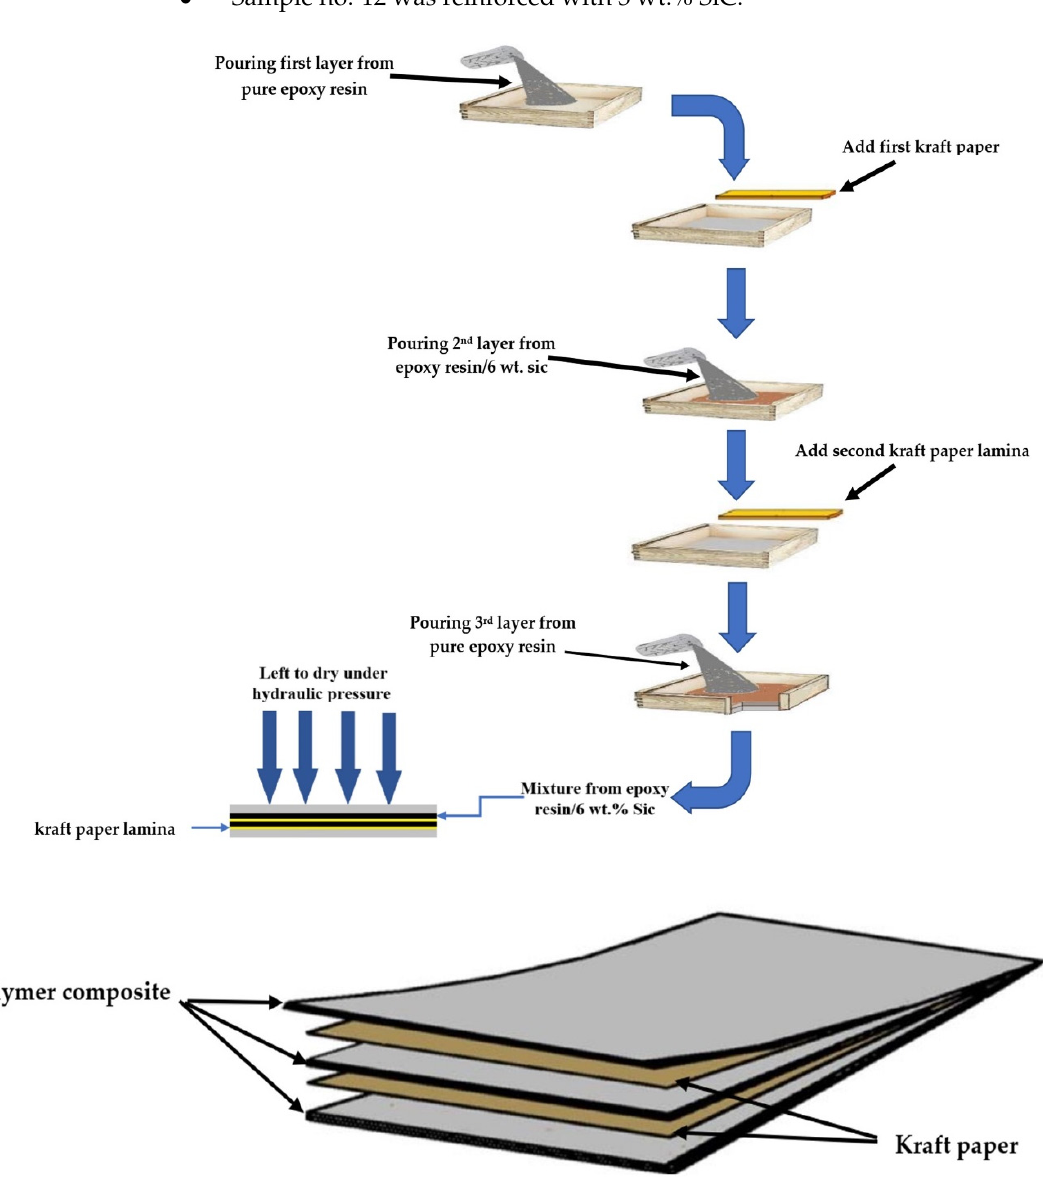
Figure 1. Flowchart representing the steps of the hand layup technique for preparing polymer composite samples.